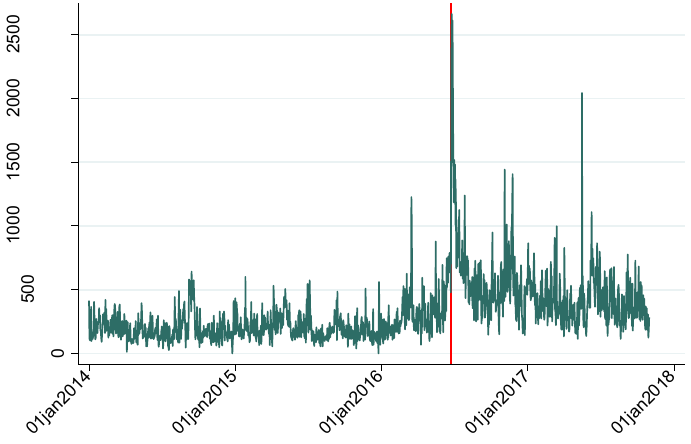
Figure 2. The UK Economic Policy Uncertainty (EPU) Index. The vertical red line corresponds to 23 June 2016, the date of the Brexit referendum. Source: the data are from Baker et al. (2016a).